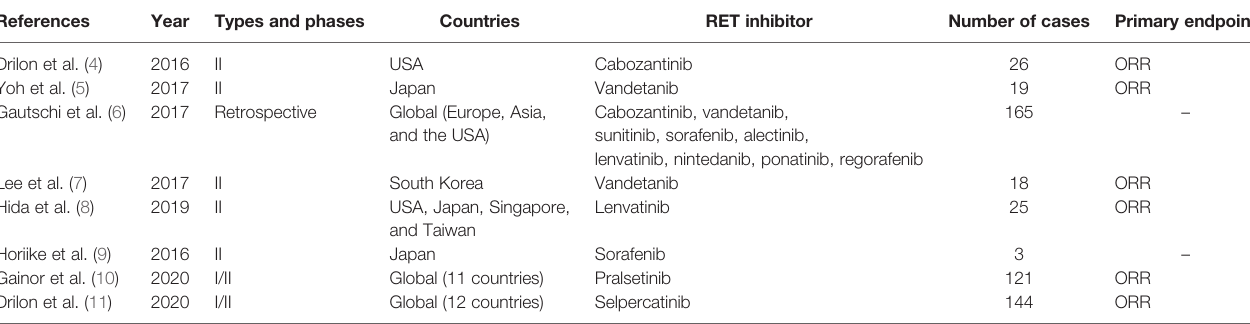
TABLE 2 | Summary of clinical trials of RET inhibitors for RET fusion-positive lung